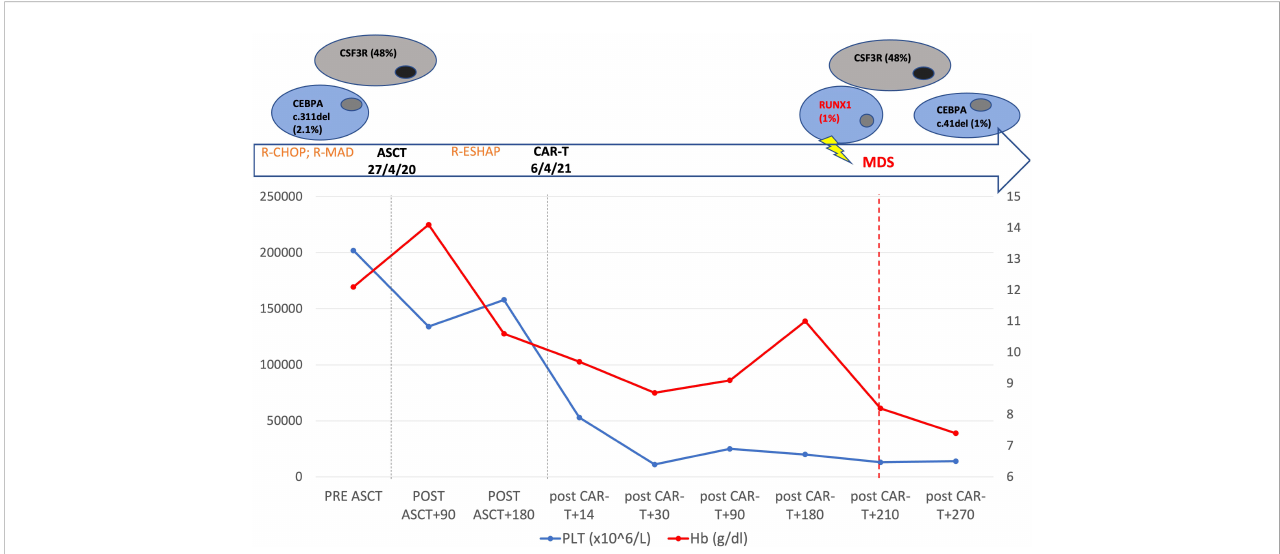
FIGURE 1 Patient ’ s timeline. Top: mutational pro fi le detected by next generation sequencing. Middle: the main patient treatments. Changes of hemoglobin and platelets from the beginning of patient therapy to 9 months after CAR T cell-therapy are